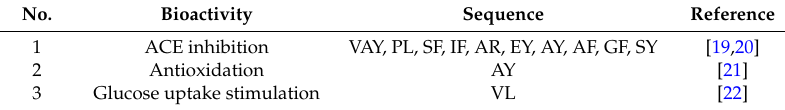
Figure 1. Distribution of the peptide library of adlay. Table 1. The known bioactive peptides by in silico proteolysis derived from adlay.